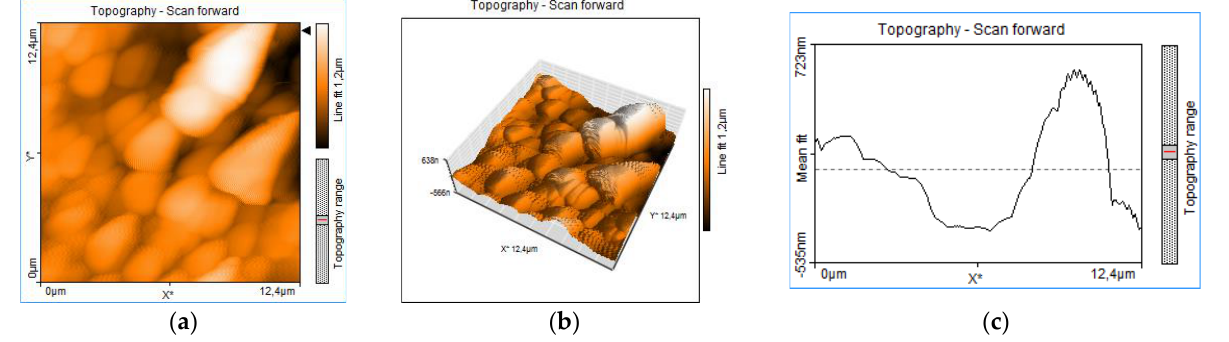
Figure 8. AFM thin film chitosan: 2D image 12 μm topography ( a ); 3D Topography 12 μm ( b ) and topography 3D line ( c ).